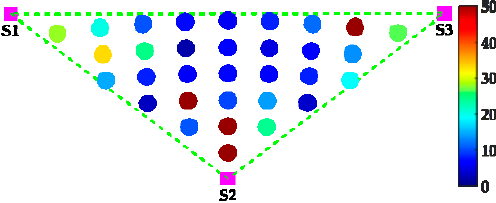
Figure 14. The distribution of absolute errors using the signals without filtering.